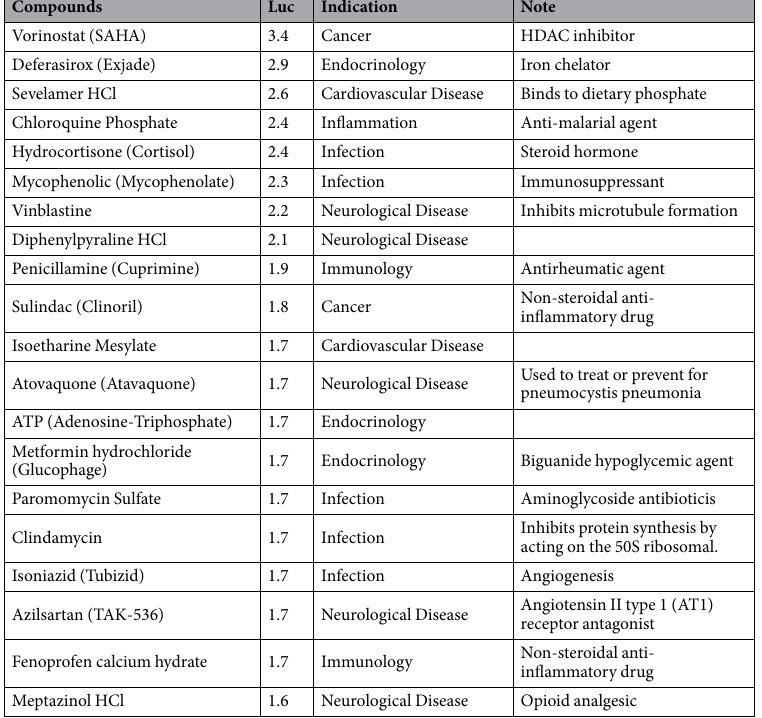
Table 1. List of parkin inducers identified by luciferase screening. HEK-parkin-Luc reporter cells were treated with each compound. Parkin promoter activities were determined based on luciferase value (Luc.). They were normalized to that of DMSO control and expressed in the table (See also Fig. 1D). The clinical indication and note are adapted from the table provided by Selleck (L1300-Selleck-FDA-Approved-Drug-Library-1172cpd-